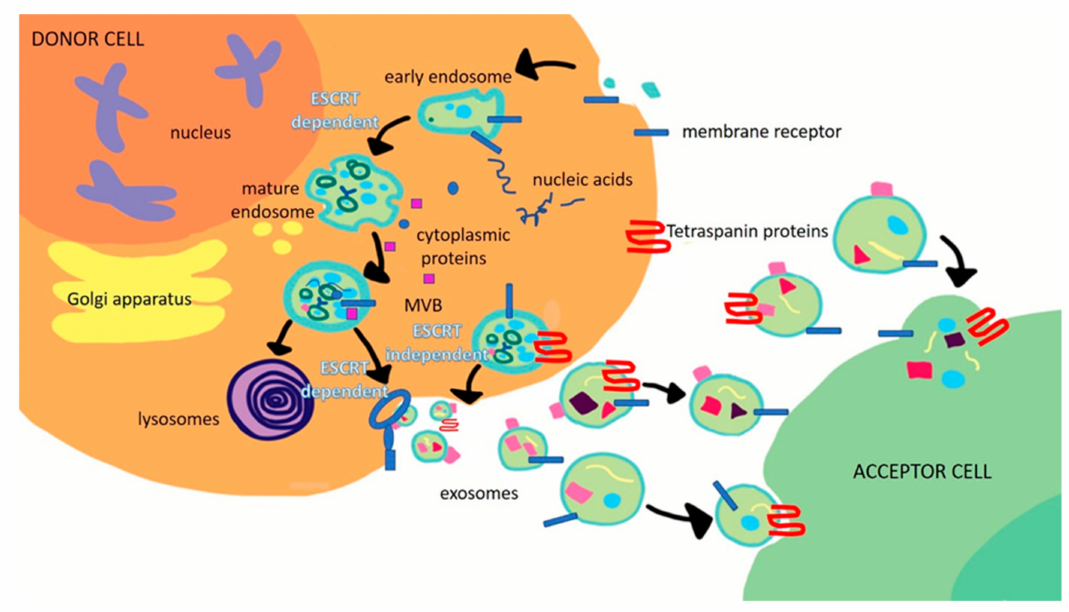
Figure 1. Scheme of the biogenesis of exosomes mainly occurring through two pathways, namely endosomal sorting complex required for transport (ESCRT)-dependent or